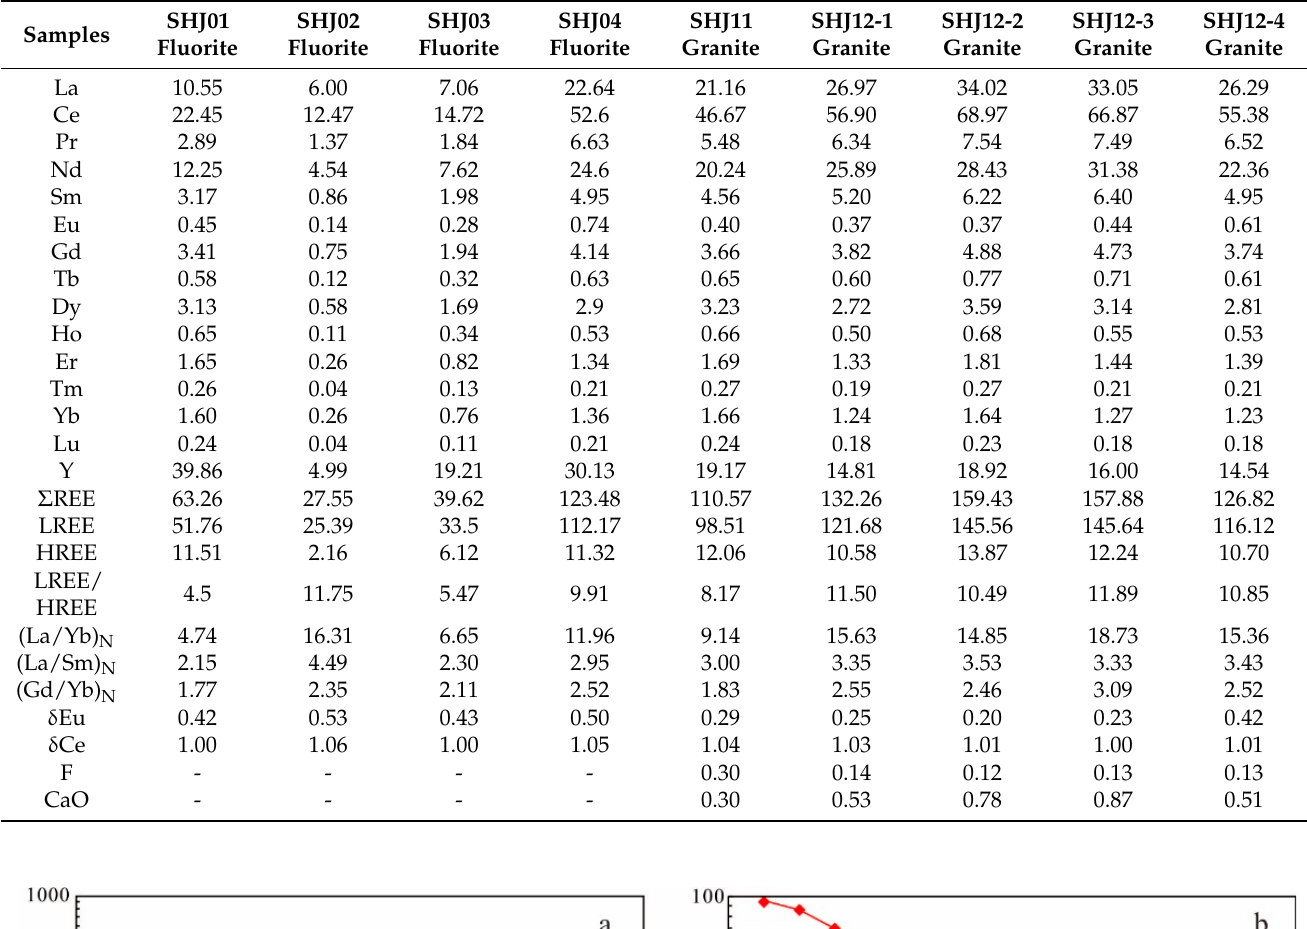
Table 3. Analytical data of REE (ppm) and CaO (wt%) for the Xiangcaoping granite and fluorite from the Shuanghuajiang fluorite deposit.